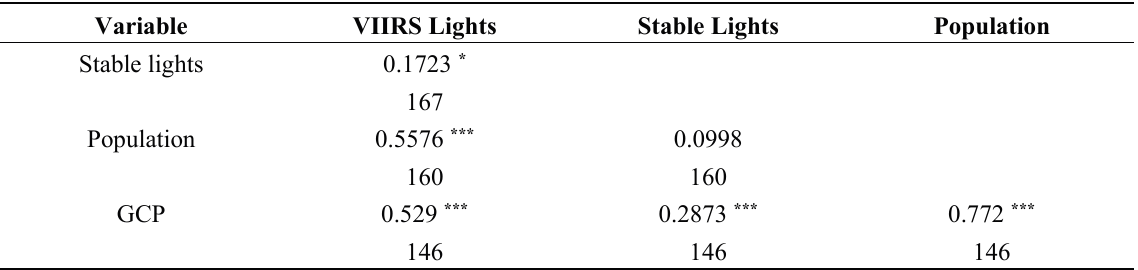
Table 3. Pairwise correlations for cells with population less than 1000 ( * p < 0.05, *** p <